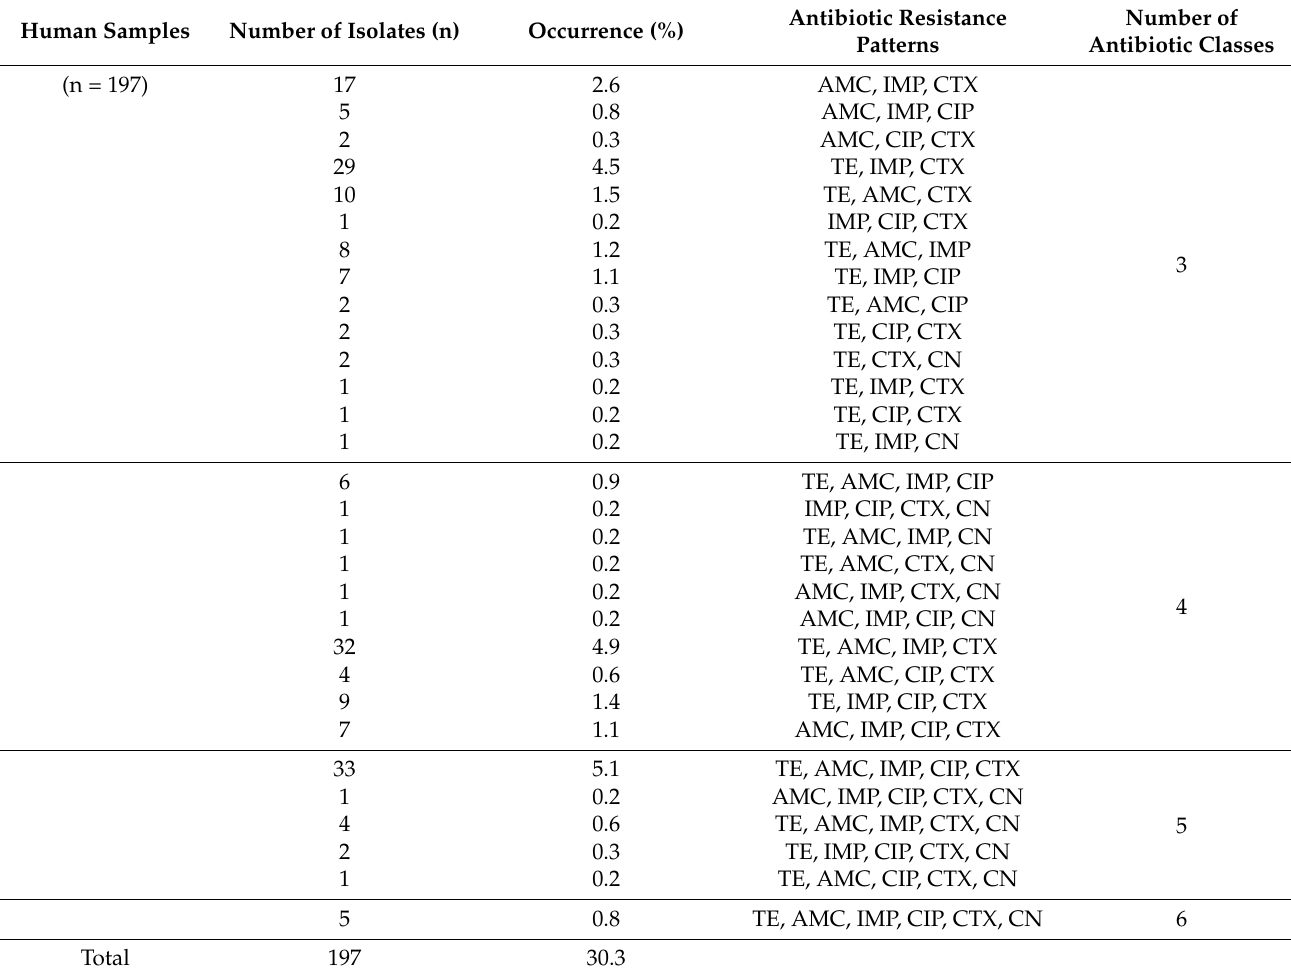
Table 5. Resistance patterns of 197 MDR E. coli isolates from human